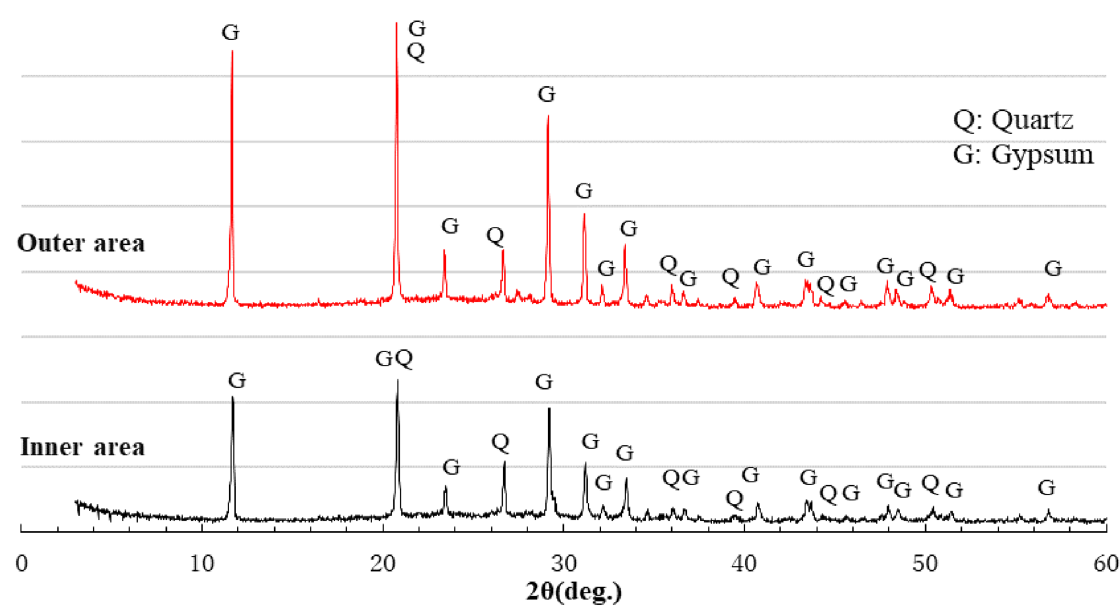
Figure 14. XRD patterns of series BFSFA(BA) after sulfuric acid immersion.